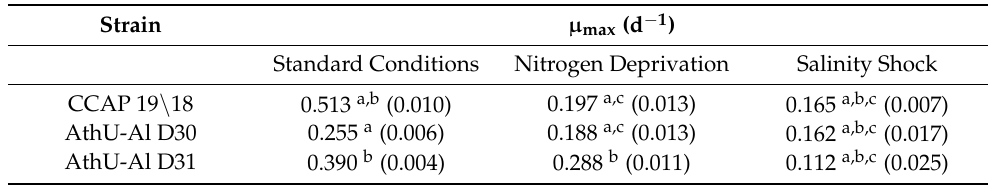
Table 1. Maximum growth rates ( μ max ) of the Dunaliella salina CCAP 19/18, AthU-Al D30 and AthU-Al D31 strains in different culture conditions.